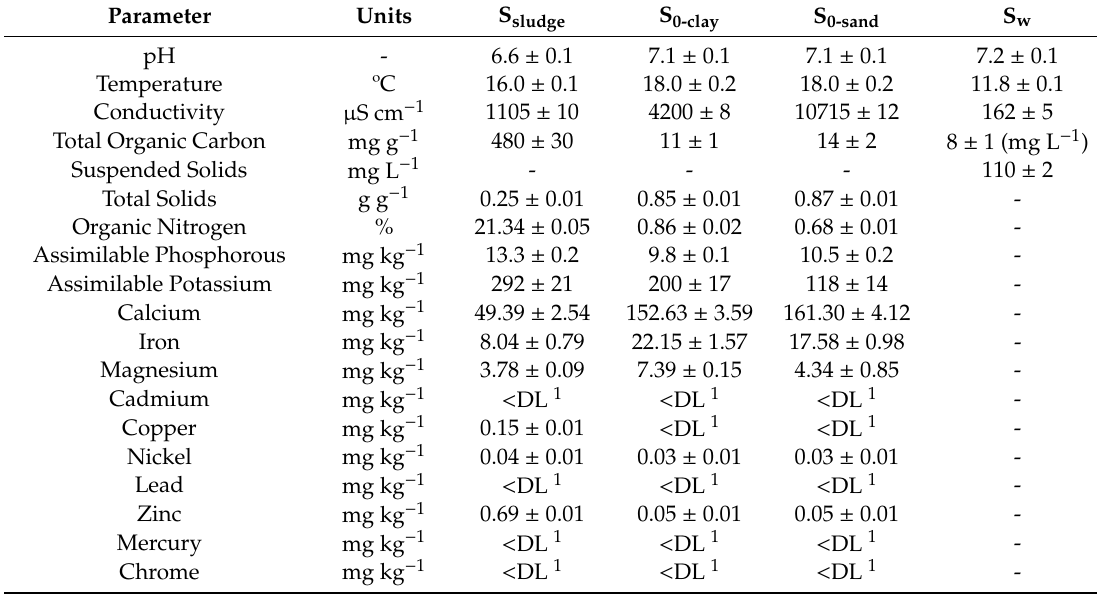
Table 5. Initial physical-chemical properties of treated sewage sludge, soils and irrigation water.